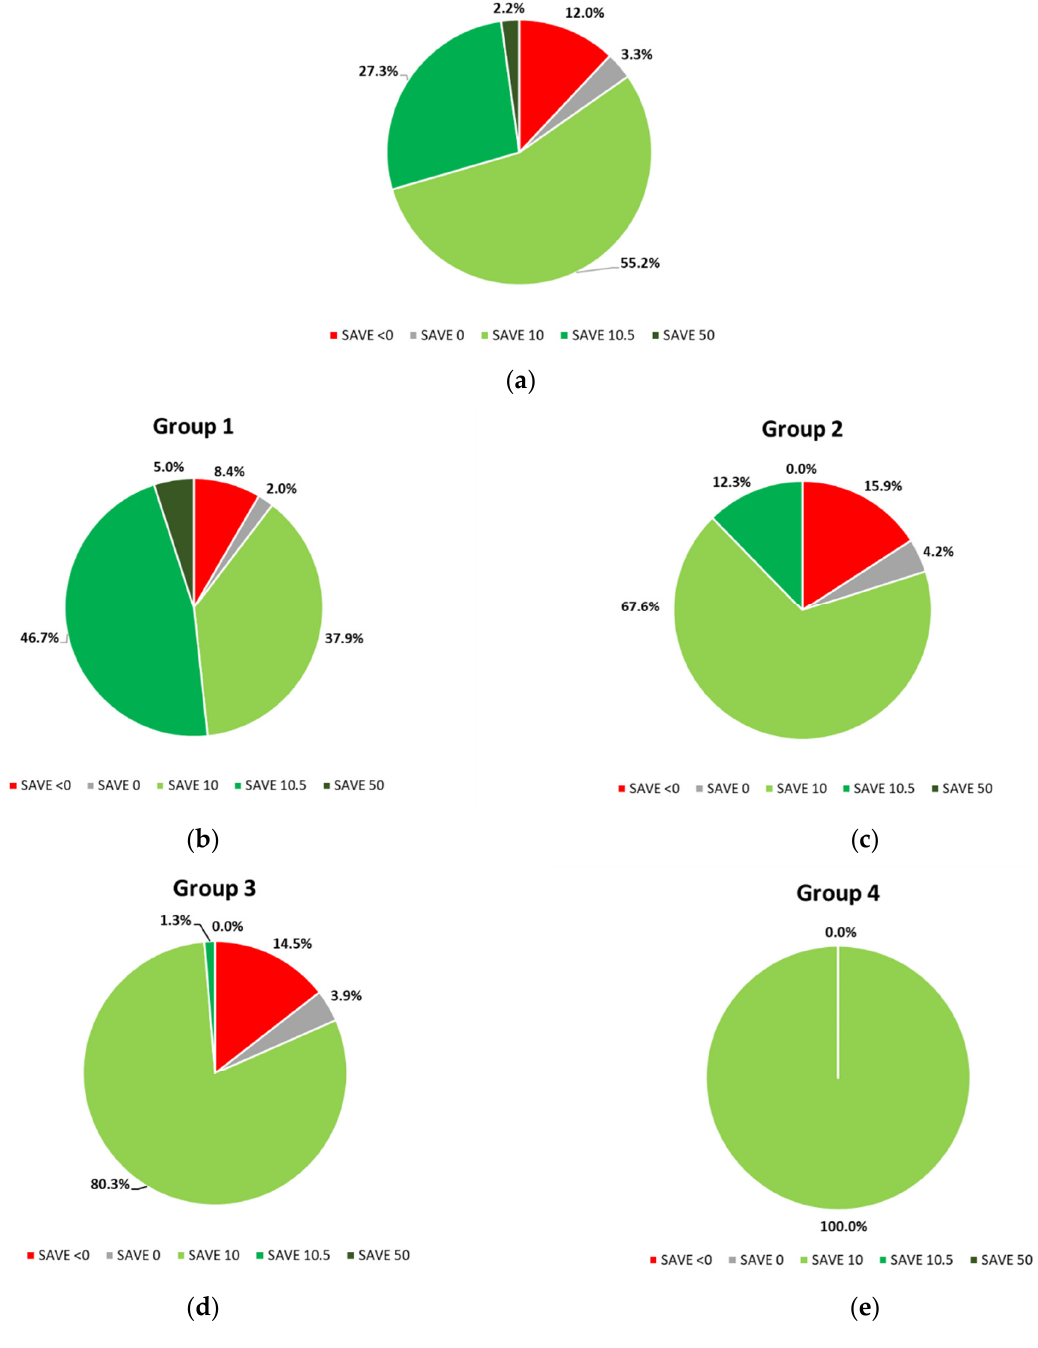
Figure 11. Economic results of the total residential users ( a ), Group 1 ( b ), Group 2 ( c ), Group 3 ( d ), Group 4 ( e ) for the year 2019. The red slice means IH is more convenient than DH; the green graduations, from light to dark green, mean DH is more convenient than IH; the grey slice means the economic results of IH and DH are the same.